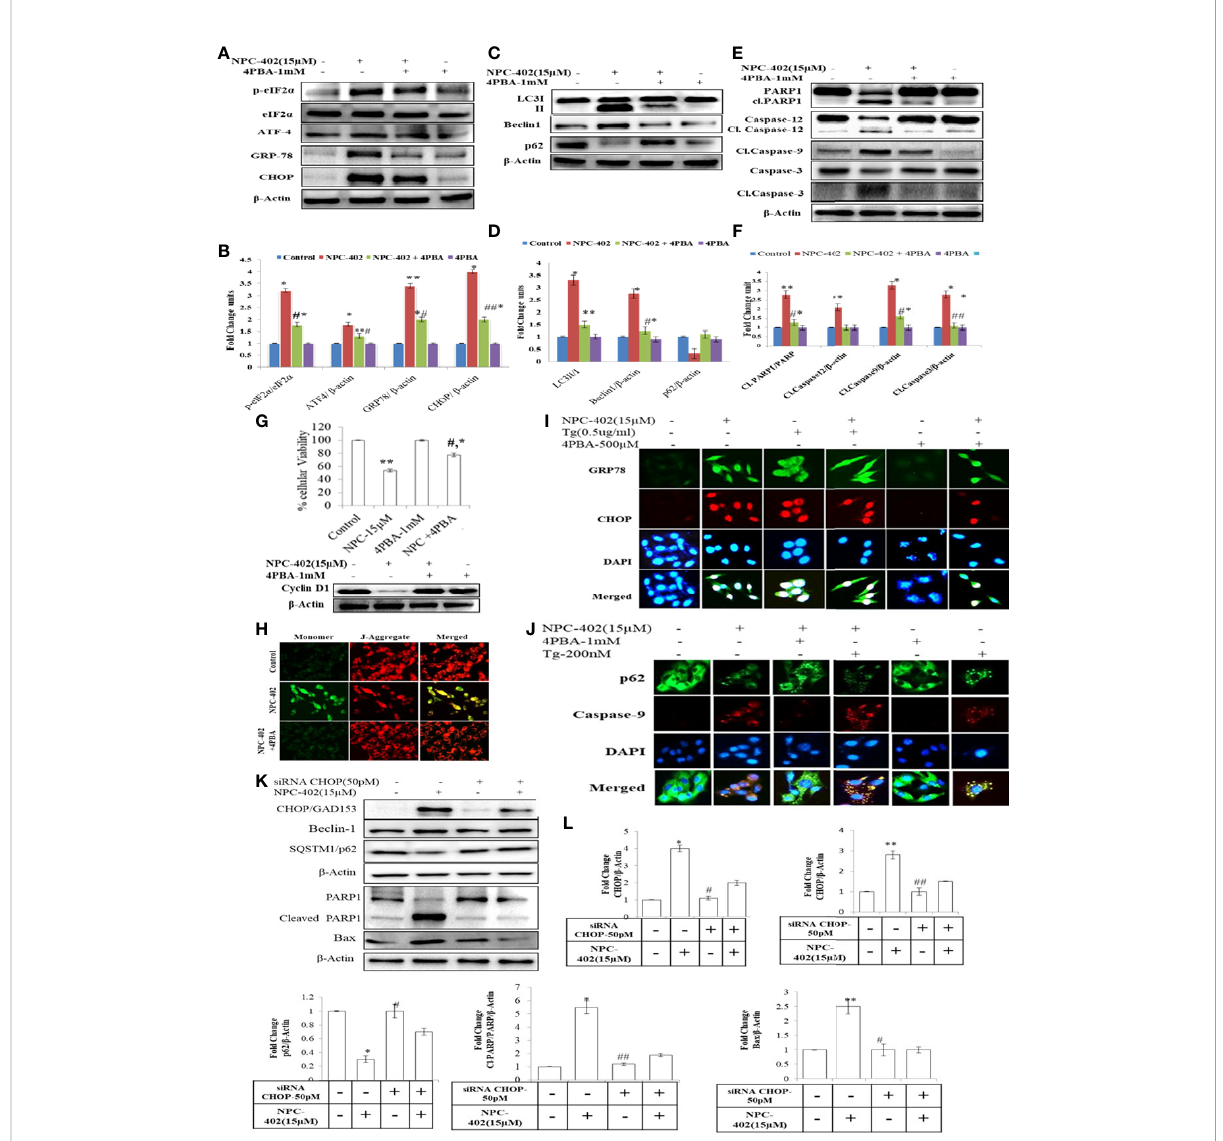
FIGURE 2 4PBA interferes with NPC-402-induced ER stress response and autophagy in B16F10 cells. (A) Represents the Western blot of protein expression of p-eIf2 a , eIf2 a , CHOP, GRP-78, and ATF4 using beta-actin as a loading control in B16F10 cells treated with NPC-402 along with/ without 4PBA. (B) Bar graph represents the densitometry analysis of ER stress proteins in fold change in comparison to beta-actin in B16F10 cells treated with NPC-402 along with/without 4PBA using Image Lab ™ Software Version 3.0 (Bio-Rad). (C) Represents the Western blot of protein expression of LC3I/II, Beclin1, and p62 using beta-actin as a loading control in B16F10 cells treated with NPC-402 along with/without 4PBA. (D) Bar graph represents the densitometry analysis of autophagy proteins in fold change in comparison to beta-actin in B16F10 cells treated with NPC-402 along with/without 4PBA using Image Lab ™ Software Version 3.0 (Bio-Rad). (E) Represents the Western blot of protein expression of PARP1, caspase-12, caspase-9, and caspase-3 using beta-actin as a loading control in B16F10 cells treated with NPC-402 along with/without 4PBA. (F) Bar graph represents the densitometry analysis of apoptosis proteins in fold change in comparison to beta-actin in B16F10 cells treated with NPC-402 along with/without 4PBA using Image Lab ™ Software Version 3.0 (Bio-Rad) . (G) Bar graph represents cell viability percentage of B16F10 cells treated with NPC-402 along with/without 4PBA. Western blot represents the protein expression of cyclin D1 in B16F10 cells treated with NPC-402 along with/without 4PBA. (H) Microscopic images represent the JC-9 staining for the detection of DY m in B16F10 cells treated with/without NPC-402 along with/without 4PBA. (I) ICC images of GRP-78 (green), CHOP (red), costained with DAPI (blue) on B16F10 treated with NPC-402 along with/without 4PBA. The images were taken at ×40 under microscope (EVOS). (J) ICC images of p62-78 (green) cleaved caspase-9 (red) costained with DAPI (blue), on B16F10 treated with NPC-402 along with/without 4PBA. The images were taken at ×40 under microscope (EVOS). (K) Represents the Western blot of protein expression of CHOP, Beclin1, p62, caspase-12, caspase-9, and caspase-3 using beta-actin as a loading control in B16F10 cells treated with NPC-402 along with/without 4PBA. (L) The bar graphs represents the fold change expression of proteins evaluated by densitometry method using Image Lab ™ Software Version 3.0 (Bio-Rad) (*p < 0.01, **p < 0.05 for control vs. NPC-402 and # p < 0.01, ## p < 00.05 for NCP-402 vs.